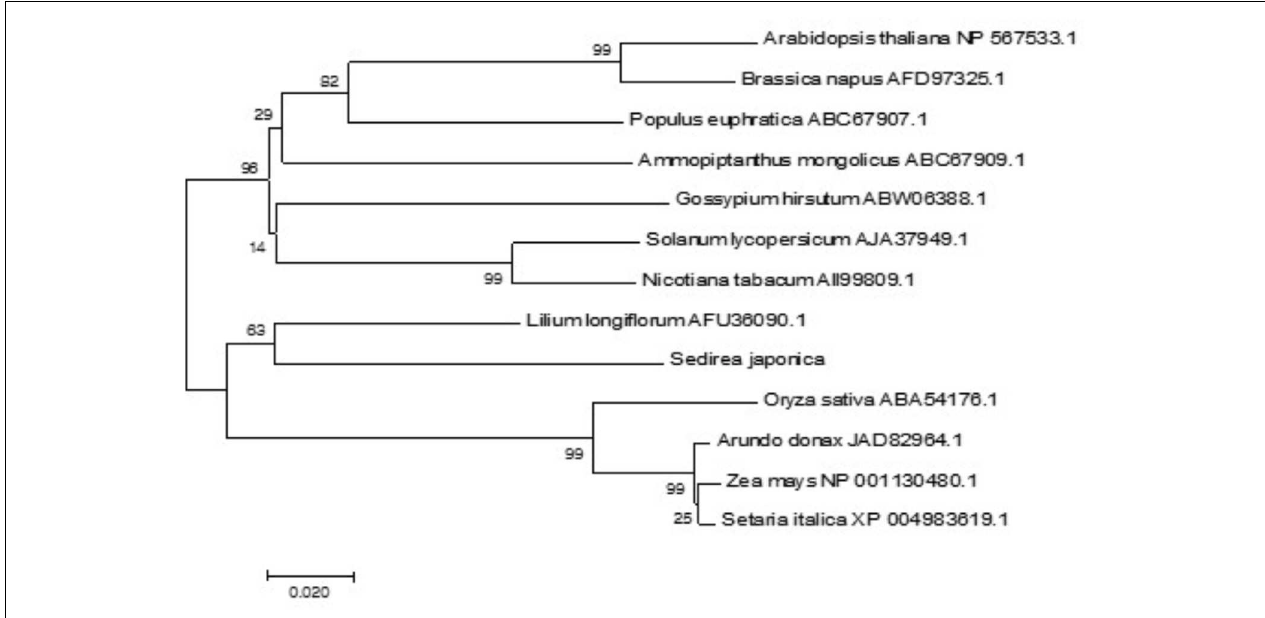
FIGURE 3 | Phylogenetic relationships of CBL1 genes in plants. Alignment of 13 full-length protein sequences and phylogenetic analyses were performed as described in “Materials and methods.” The accession numbers of the CBLs are presented next to the species names. The optimal tree with the sum of branch length = 0.83257379 is shown and bootstrap values are indicated at the respective branches. The tree is drawn to scale, with branch lengths in the same units as those of the evolutionary distances used to infer the phylogenetic